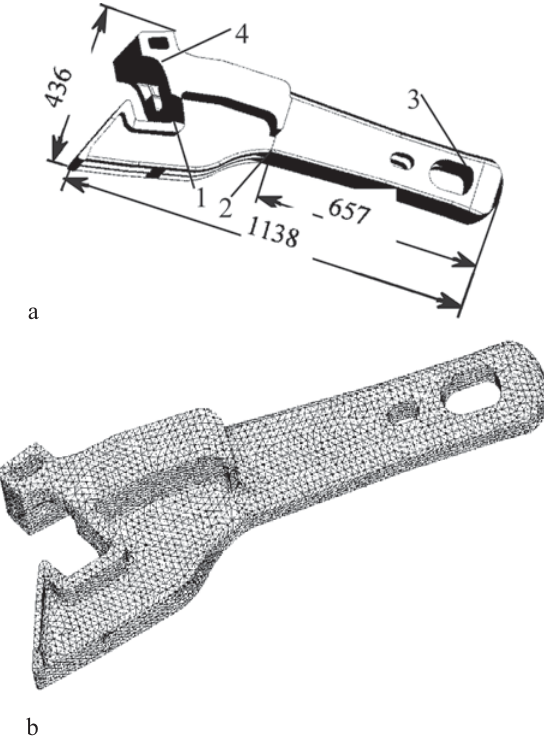
Fig. 2. Th e body of the automatic coupler in railway carriages (a); 3D FEM mesh for the automatic coupler (b)